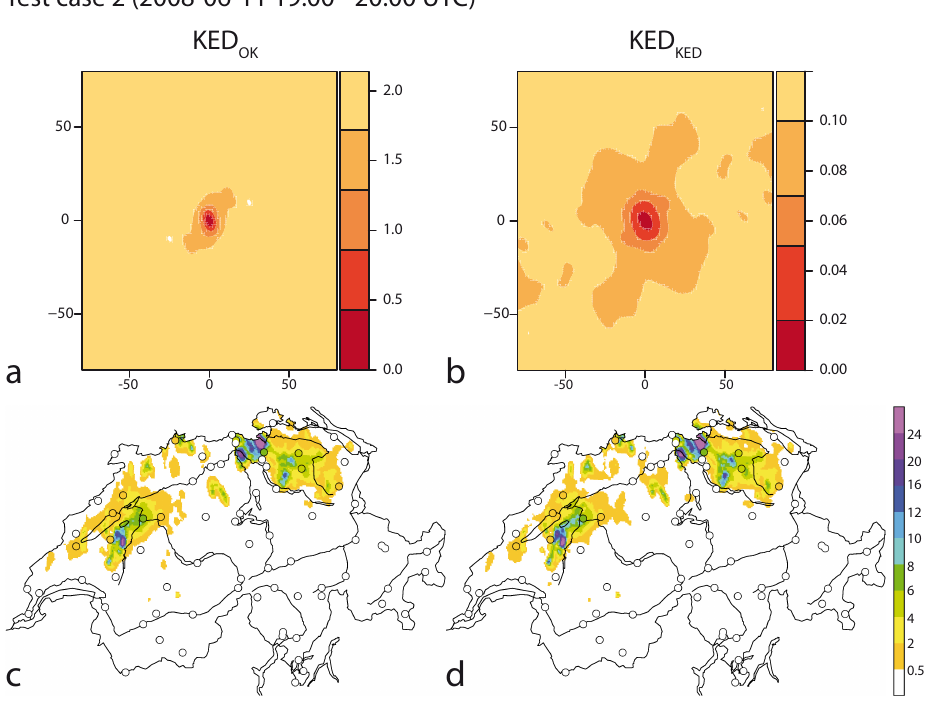
Fig. 9. As Fig. 7 but for test case 2.